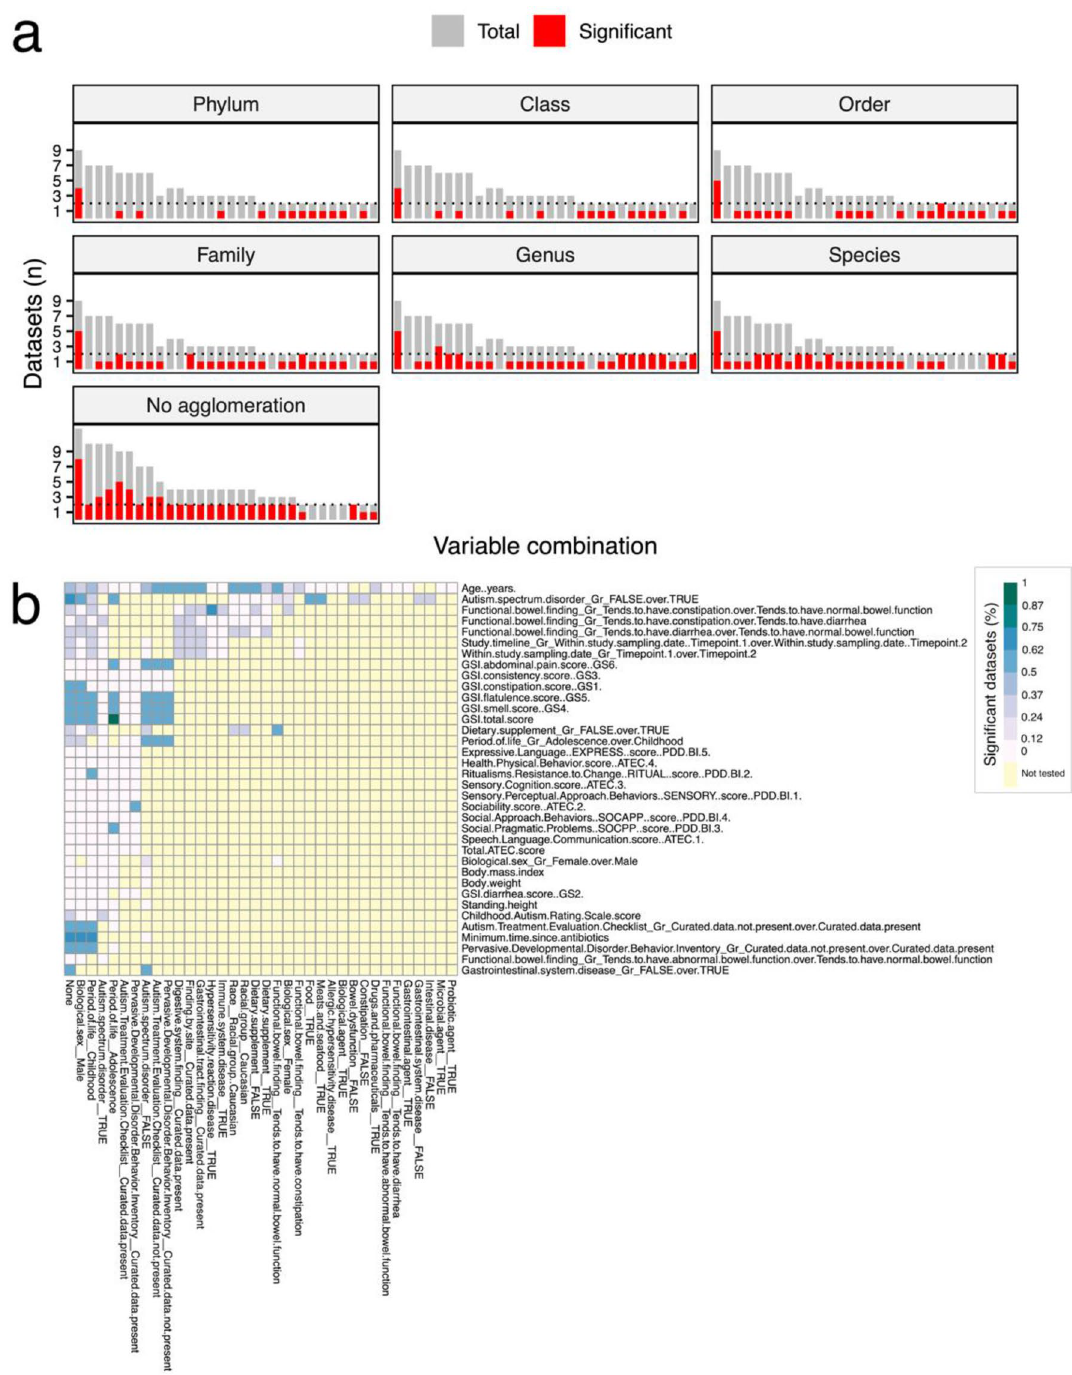
Figure 2. Variables associated with beta-diversity in multiple datasets. ( a ) Variables/combinations significantly associated with changes in bacterial community structure in at least 2 datasets are plotted. Each bar represents the total number of datasets in which a variable (or variable combination) was tested and the red fraction of the bar denotes the number of datasets where the difference in beta-diversity was significant (PERMANOVA, P < 0.05). The first bar in each panel represents the variable “Subset: None; Autism Spectrum Disorder—FALSE over TRUE.” Remaining variables are listed in Supplementary file 1: Table S3. ( b ) Proportions of datasets with significant tests (non-aggregated data) for each variable combination are plotted. Columns are used to arrange subset values while rows segregate test variables. Results from aggregated data (genus and species levels) are presented in Supplementary file 2 (Figs. S4,